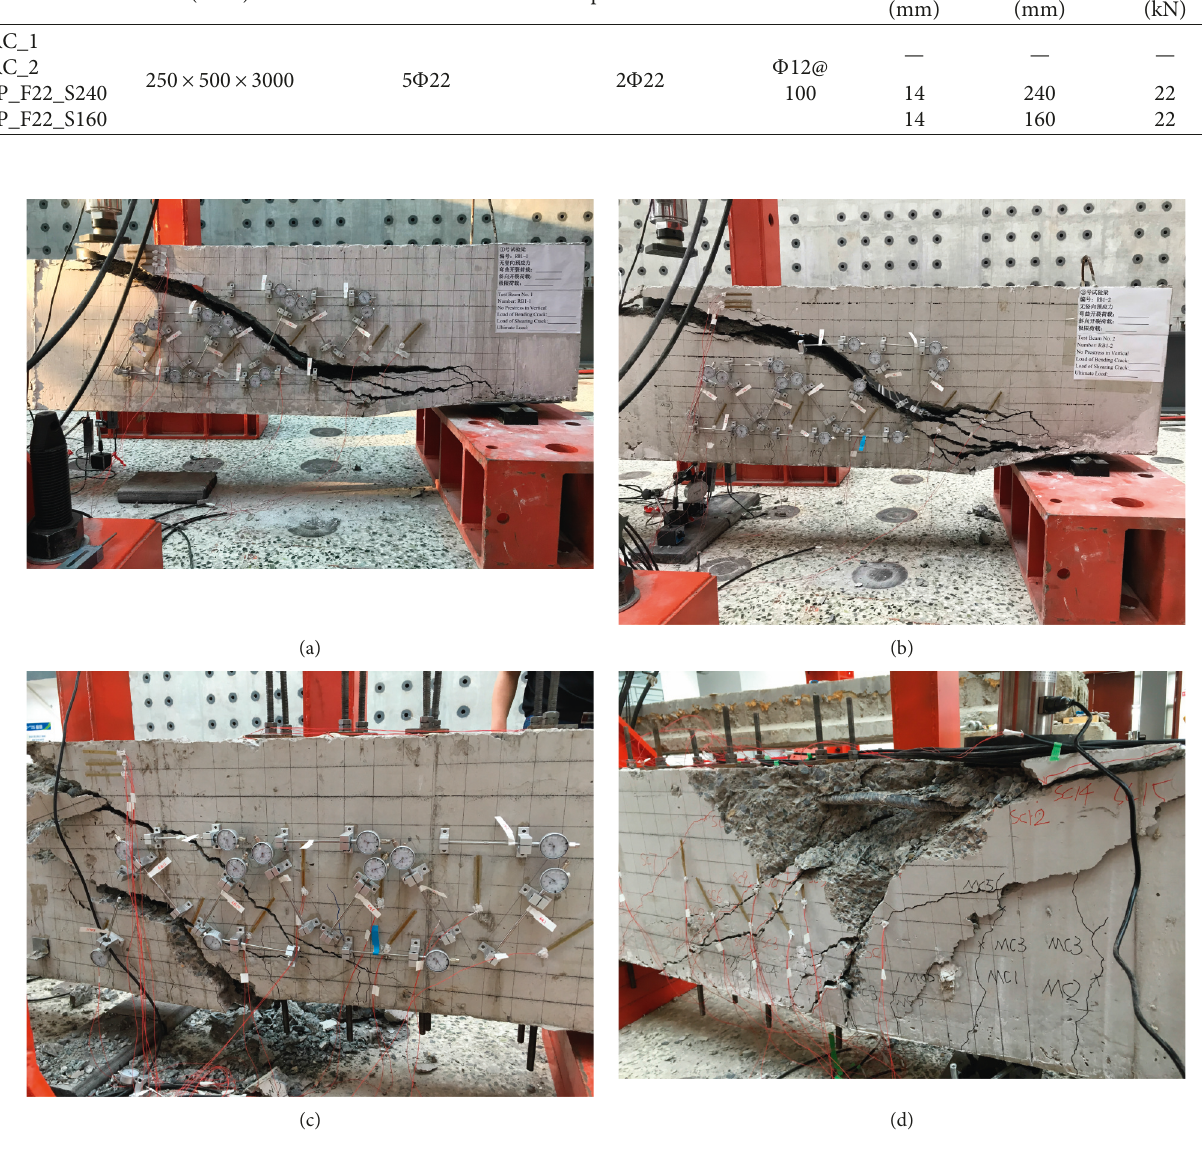
Figure 3: Cracking mode of a partial specimen under shear failure. (a) RC_1. (b) RC_2. (c) IP_F22_S240. (d)